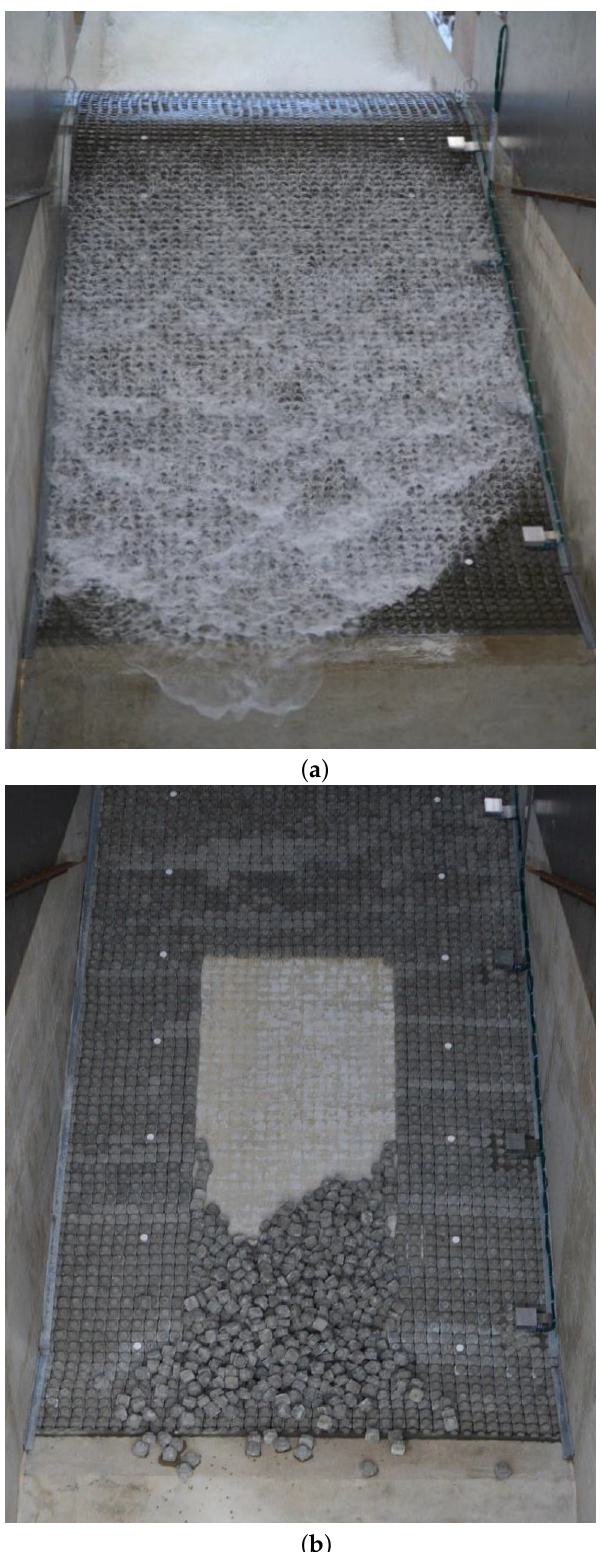
Figure 4. ( a ) Wave overtopping during Test A [13]. ( b ) Damage on Grassblocks after Test B